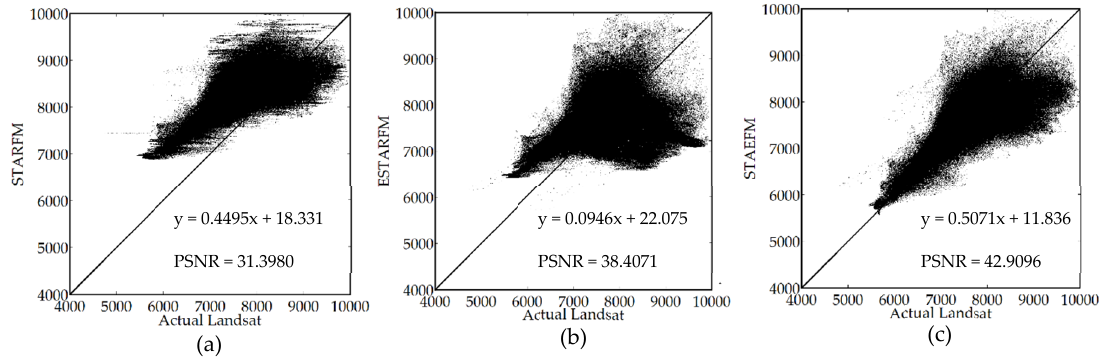
Figure 6. Histograms of LST images from ( a ) Landsat, ( b ) STARFM, ( c ) ESTARFM, and ( d ) STAEFM on 18 January 2019.